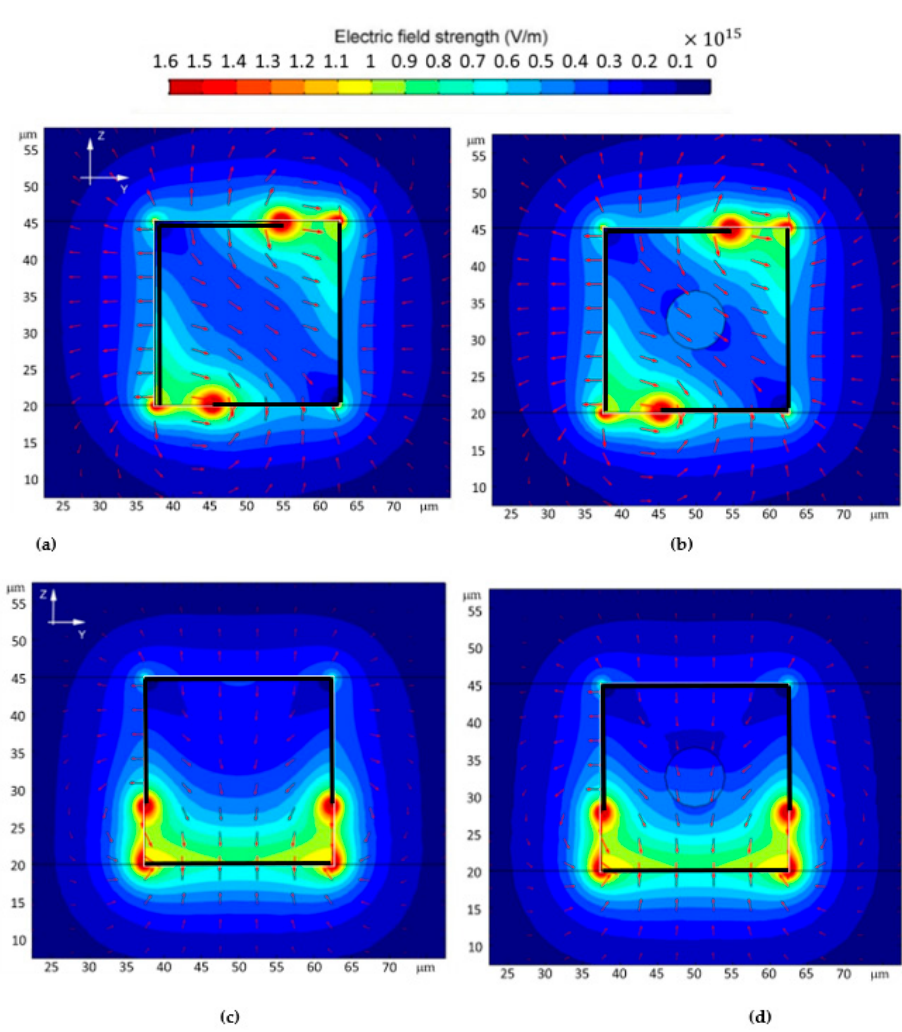
Figure 9. Electric field strength in the detection volume with and without 8 μ m RBC in 25 μ m microfluidic channel for; ( a , b ) 3D L-shaped ( c , d ) 3D Ω -shaped.